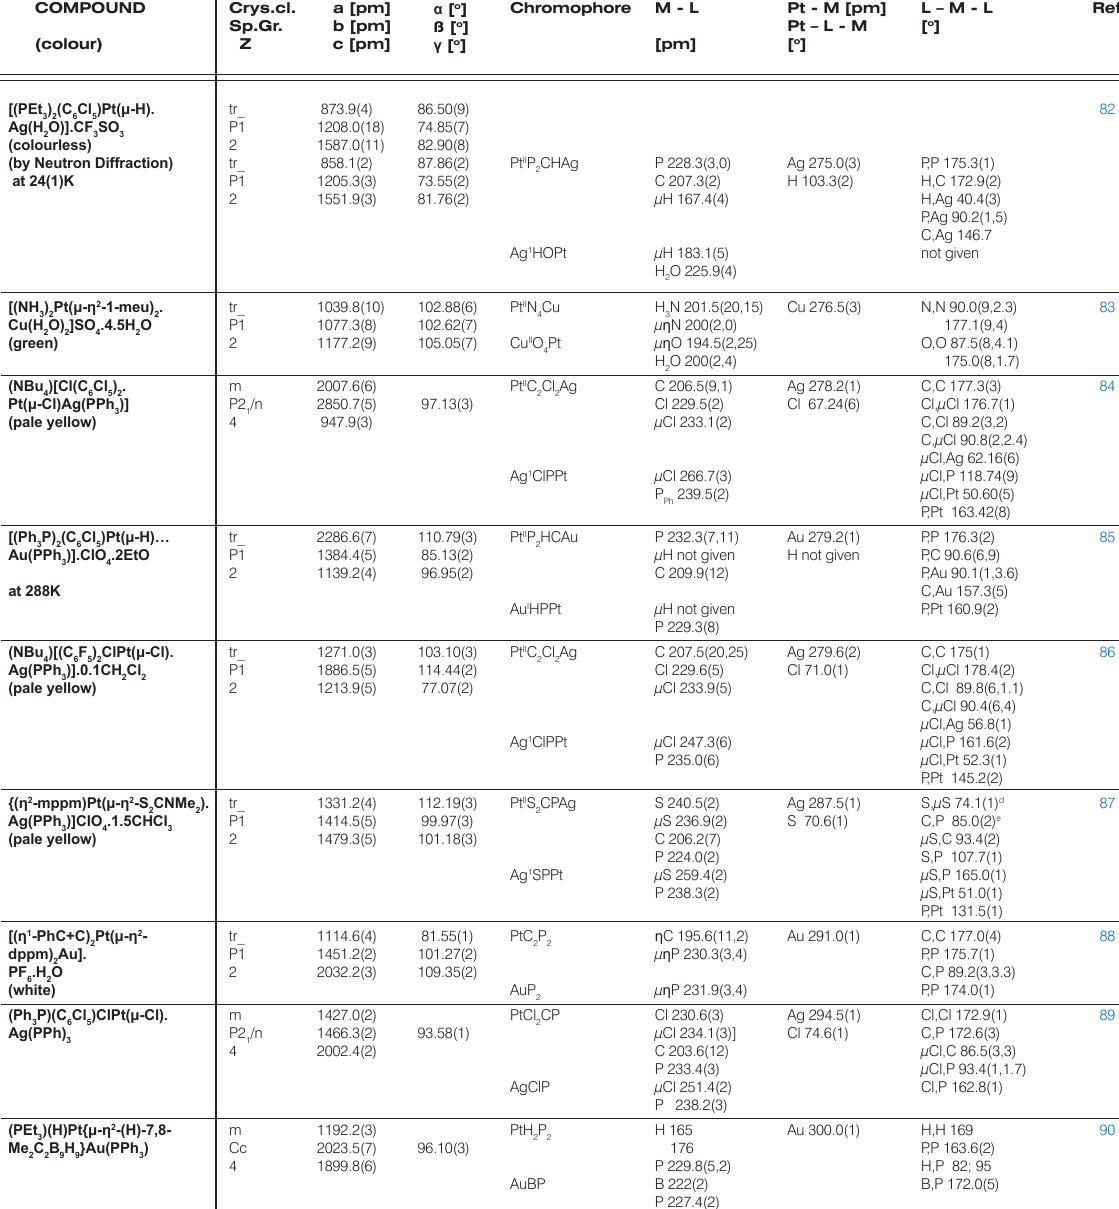
c Three member metallocyclic ring. d Four member metallocyclic ring. e Five member metallocyclic